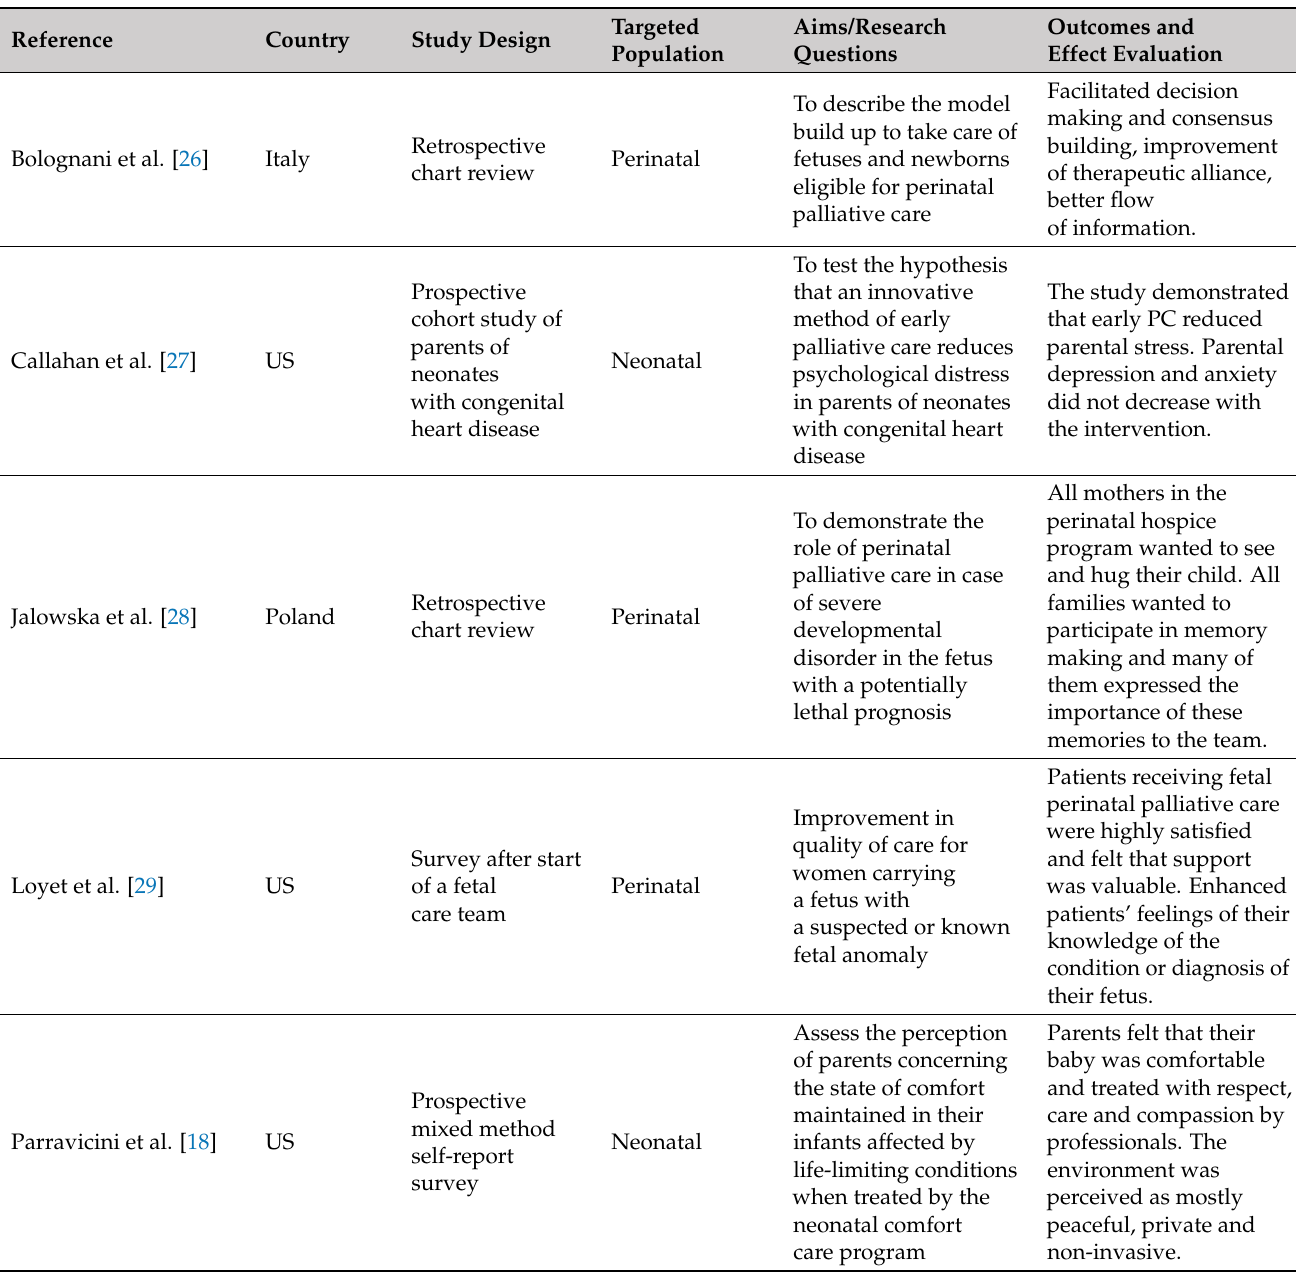
Table 3. Characteristics of included publications discussing outcomes and effect evaluation of perinatal palliative care